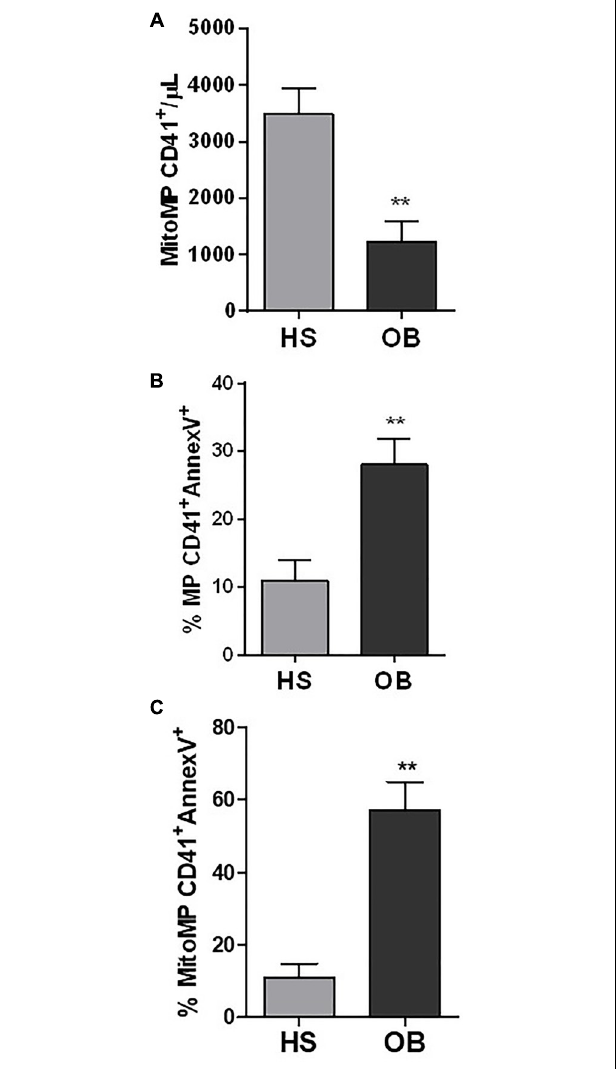
FIGURE 8 | Characterization of platelet-derived MPs isolated from healthy (HS) and obese (OB) individuals by flow-cytometry. (A) The count of platelet mitoMP CD41 + was reported as the number of mitoMP/ µ L. (B) The % of MP CD41 + /Annexin V + and (C) mitoMP CD41 + /Annexin V + are reported. ∗∗ P < 0.01 vs. HS ( n = 4 for each